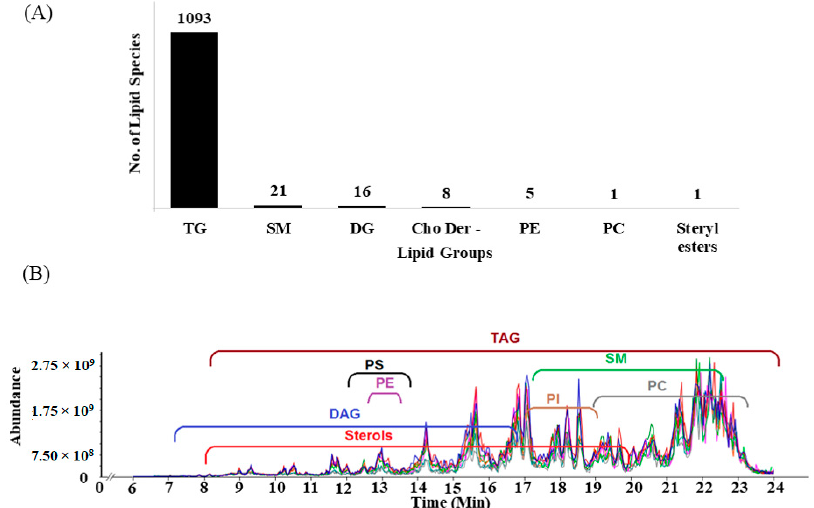
Figure 1. Di ff erent classes of lipids identified: ( A ) subclass-wise breakdown of the manually graded